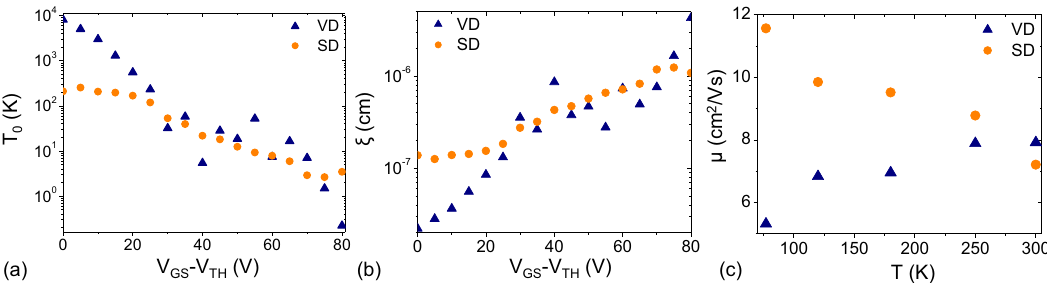
Fig. 4 Effect of LTES on screening, carrier localization and carrier mobility in the channel. a The characteristic temperature is plotted against gate overdrive voltage. A typical drop in T 0 with overdrive voltage is observed. However, T 0 values for SD are more than an order smaller than those for VD. This implies weaker temperature dependence of G which means LTES results in weaker hopping transport in MoS 2 . b Localization length is plotted as a function of gate overdrive voltage. As a result of LTES, carriers are found to be weakly localized which is inferred from the observed increase in the localization length in SD. c Field-effect mobility is shown as a function of temperature for virgin and stressed device. SD exhibit much higher mobility at low temperature which suggests that CI scattering is suppressed as a result of LTES. Moreover, high-temperature mobility remains